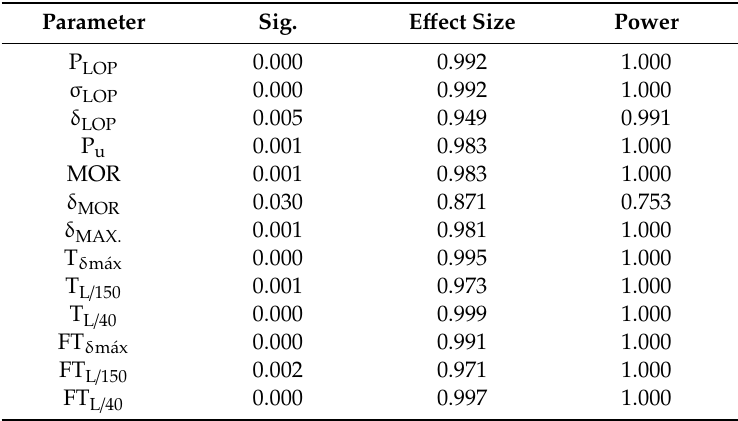
Table 6. Results of the univariate analysis of variance